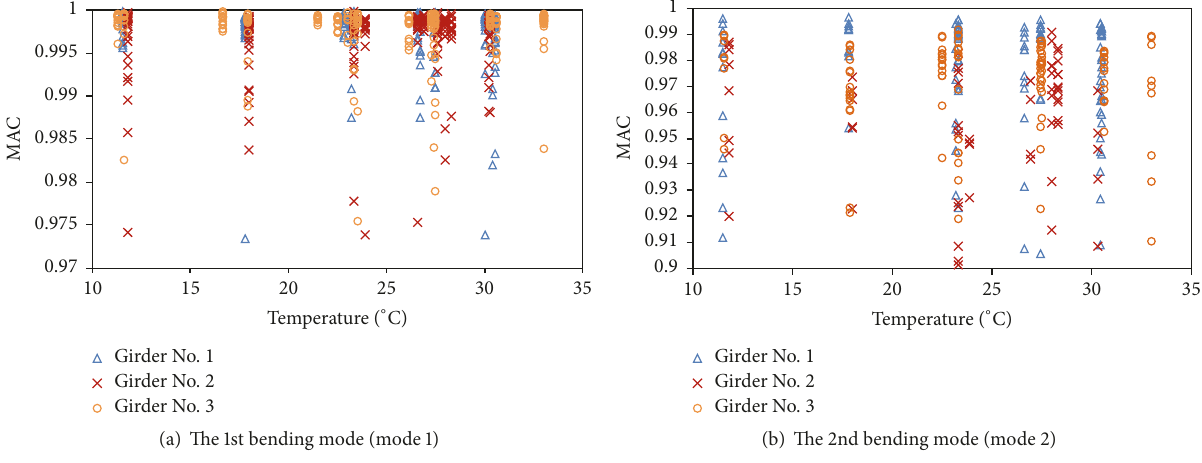
Figure 19: ((a)-(b)) Identified MAC values of two bending modes versus measured ambient temperature.